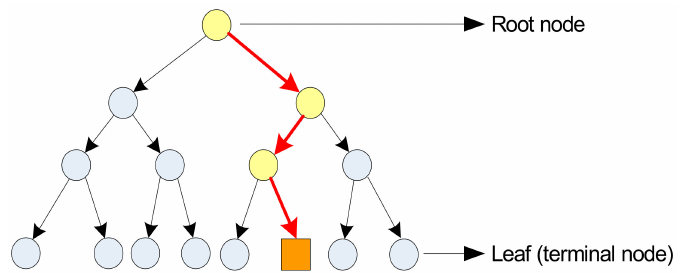
Figure 7. Conceptual diagram of decision tree (DT) model.